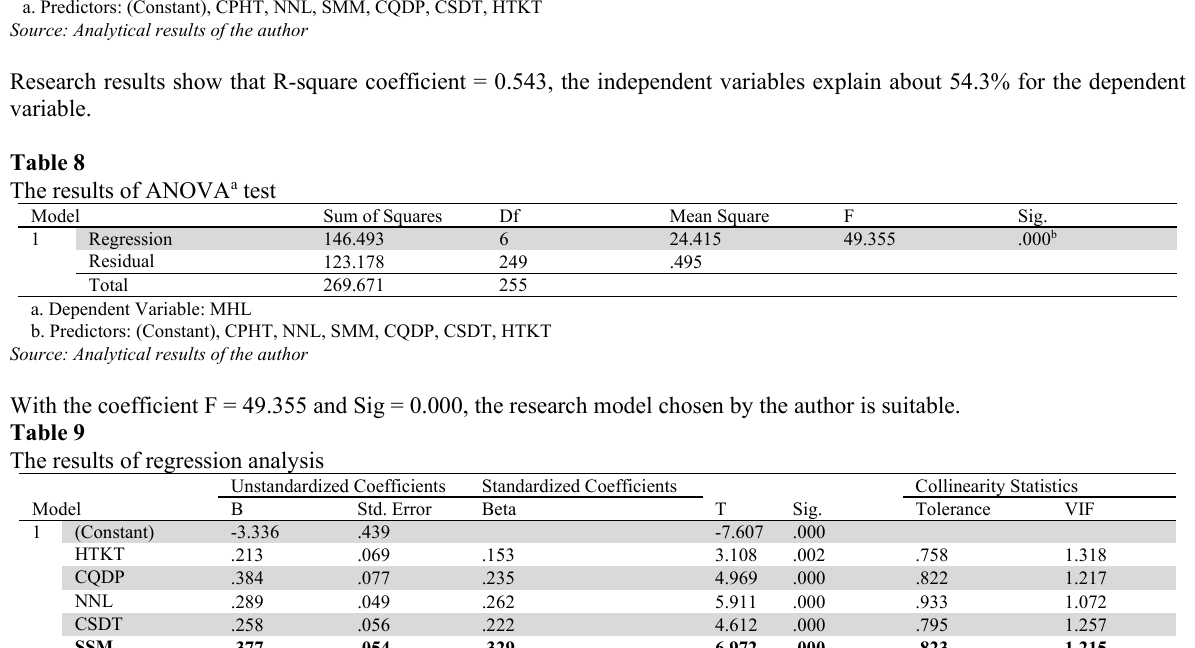
Model summary Model